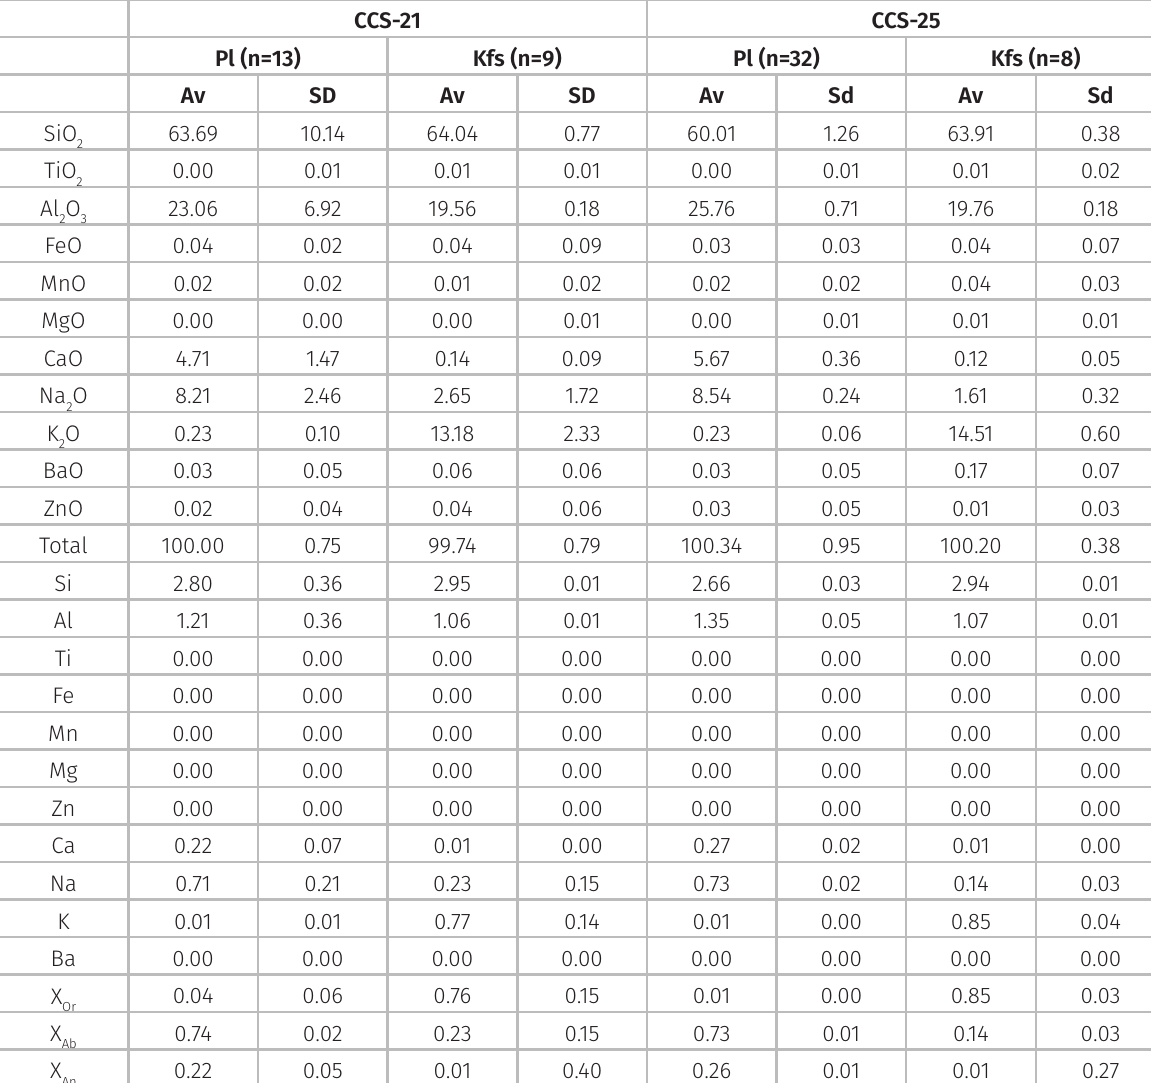
Table II. Average (Av) and standard deviation (SD) of the mineral chemistry of feldspars in matrix. Calculations based on 8 oxygens, according to parameters of Deer et al.